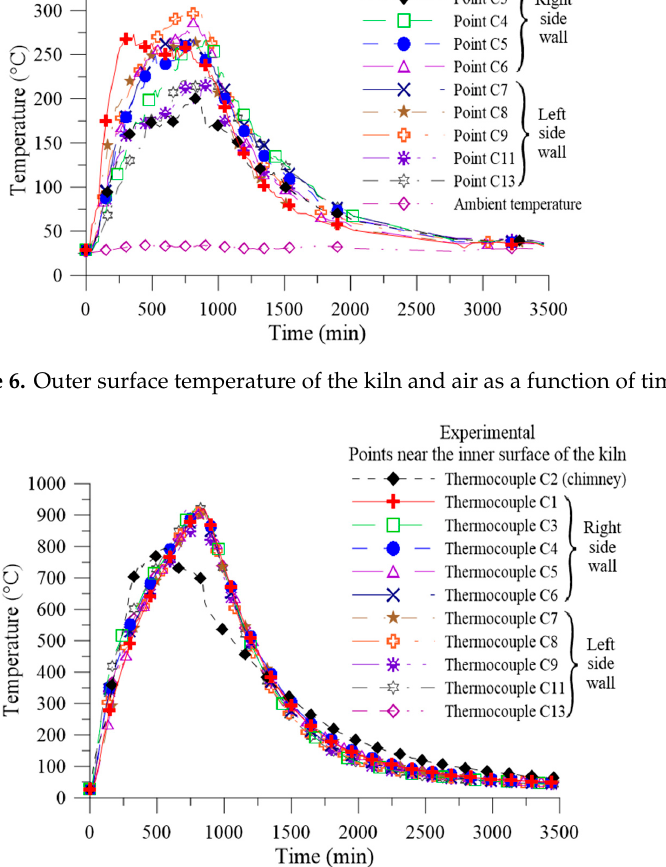
Figure 7. Temperature near the inner surface of the kiln and chimney as a function of time.